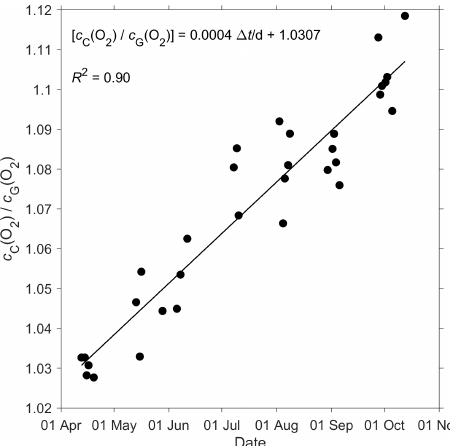
Figure 3. A linear fit of the ratio between the daily median of the discrete oxygen samples ( c C (O 2 )) and glider oxygen data ( c G (O 2 )) for σ 0 > 1028kgm − 3 was used to derive the c G (O 2 ) drift and ini- tial offset at deployment. The time difference (cid:49)t is calculated with respect to the deployment day on 16